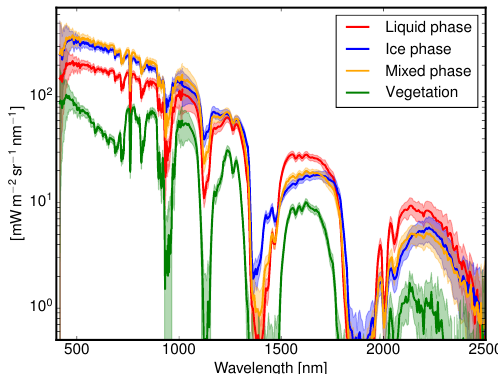
Figure 21. Spectral transmission and calculated reflection loss of the HALO side view port.